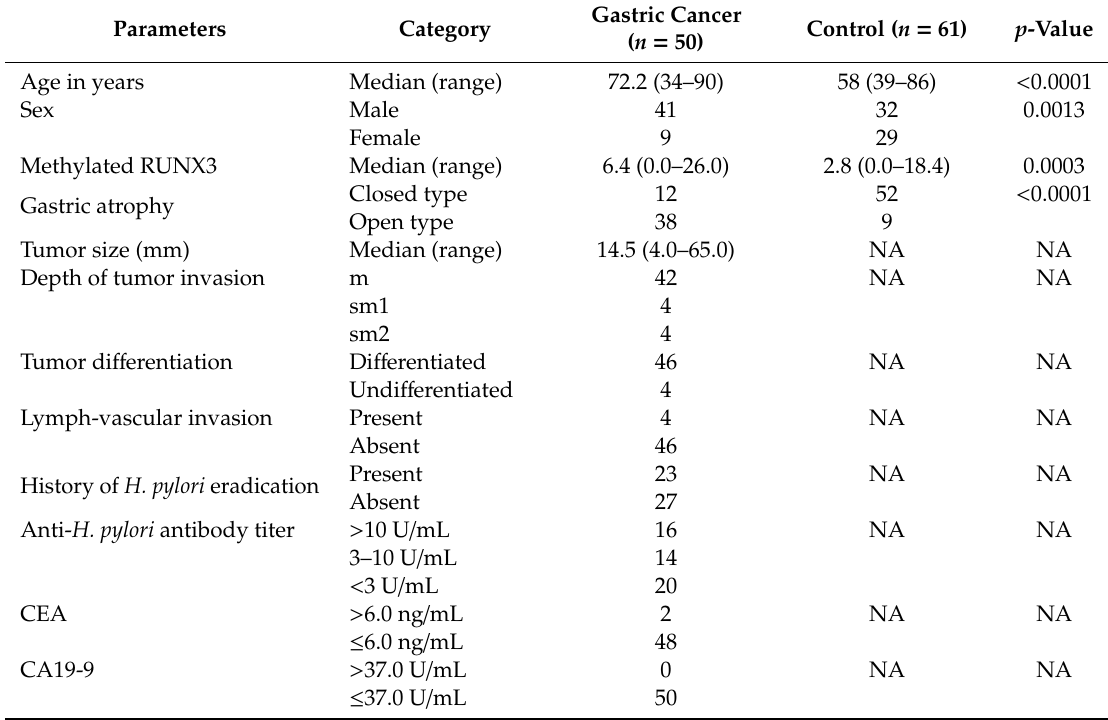
Table 3. Clinicopathologic characteristics of the